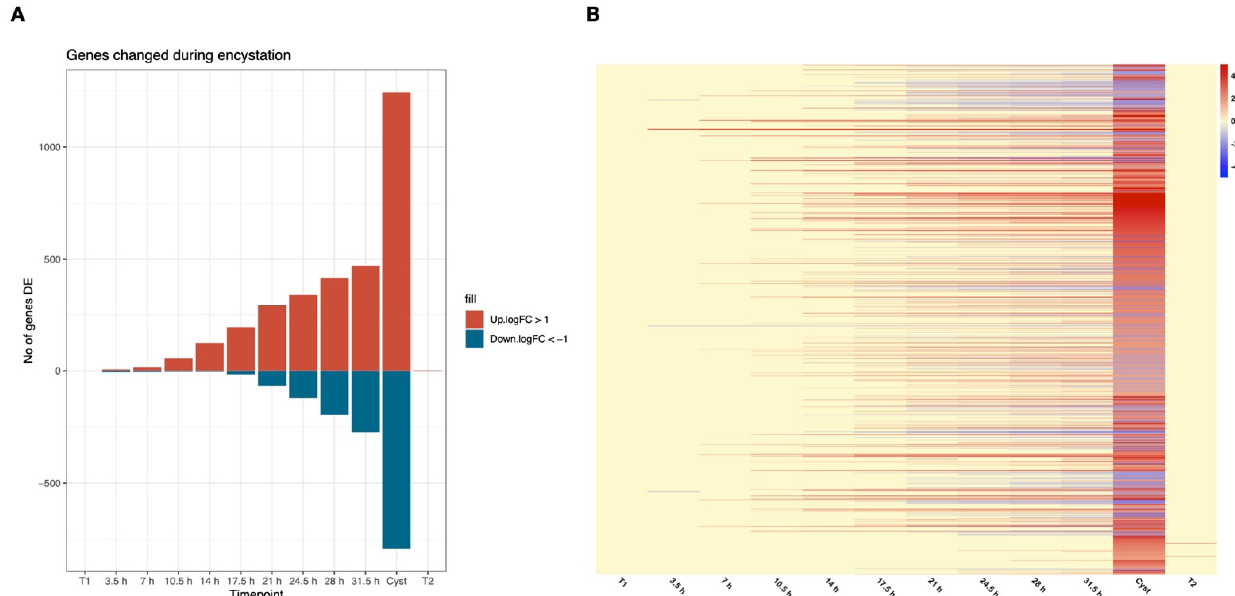
Figure 1. Overall gene expression changes during Giardia encystation: ( A ) Number of significantly differentially expressed genes (DEGs) compared to starting trophozoites (T1) with a log2-fold change of more than one, which equals a fold change of 2 or bigger separated by timepoints; ( B ) heat-map of log2–fold changes of the top 1000 most changed DEGs in cysts including all timepoints. Changes are capped at -5 and 5, respectively, to improve visualization. Up-regulation is shown in red, while down-regulation is shown in blue. Table 1. Number of DEGs at each timepoint during encystation and excystation of Giardia .